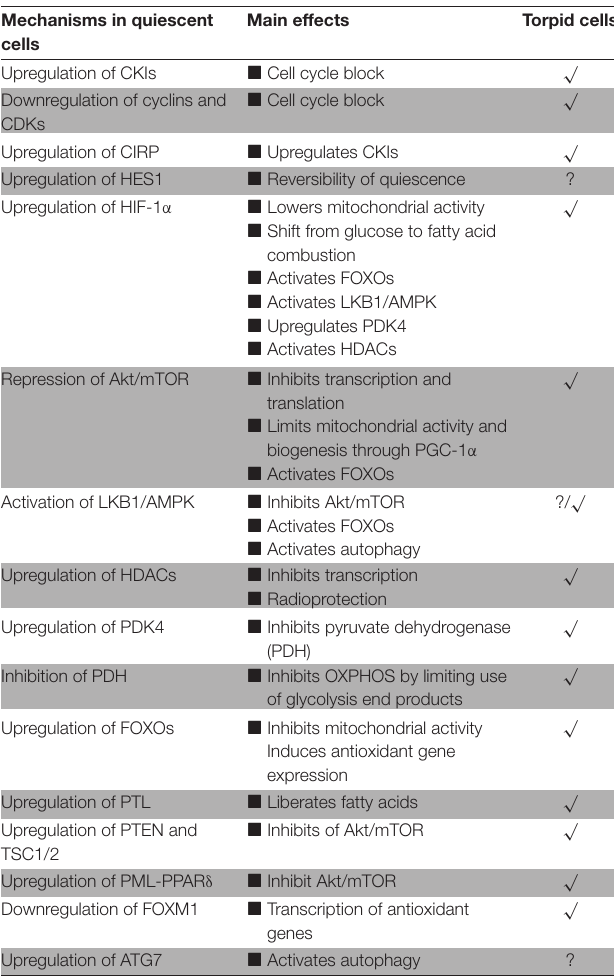
TABLE 1 | Comparison of key events driving quiescence in cells to those found in torpid